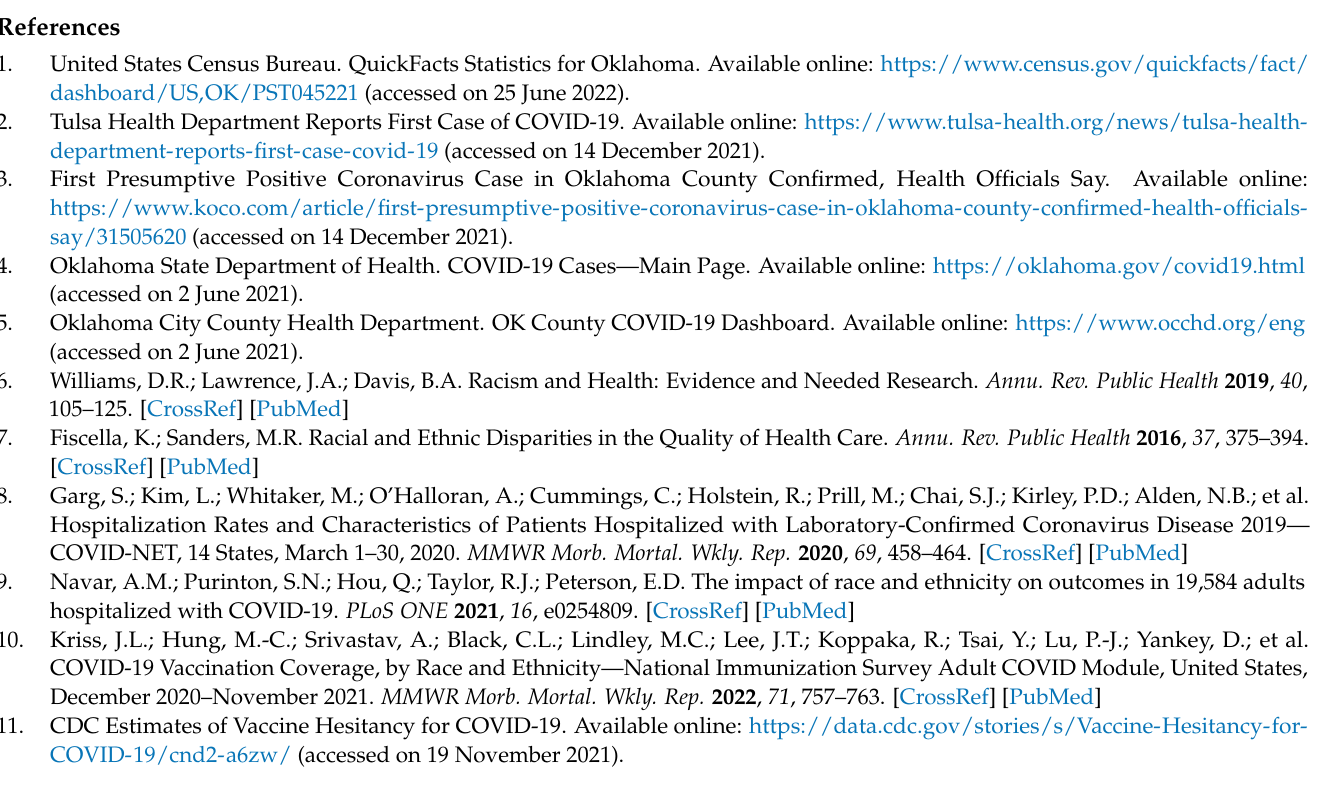
Figure A2. Distribution of comorbidities in COVID-19 patients by race/ethnicity.